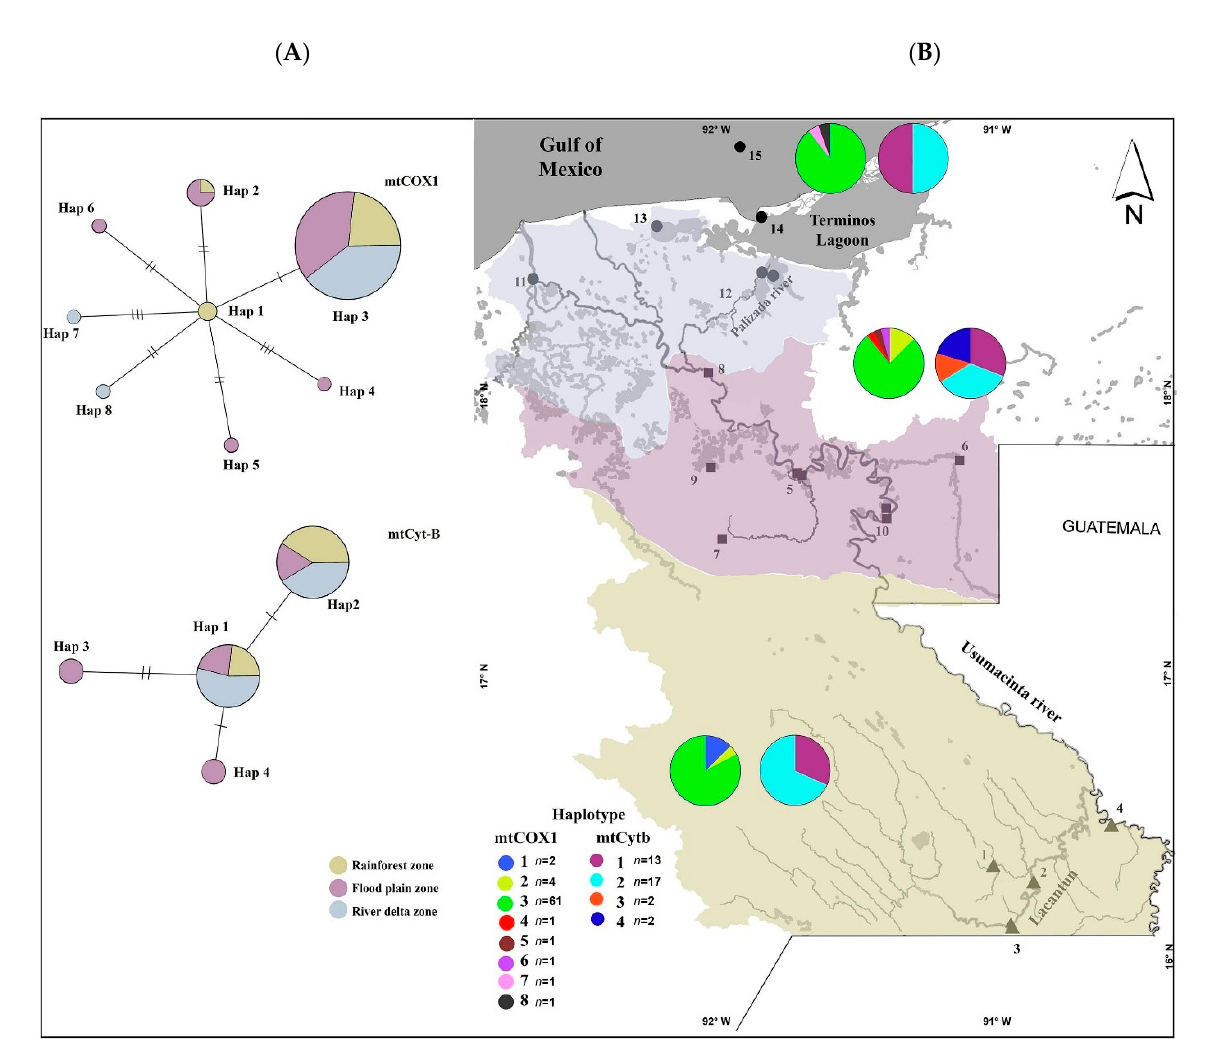
Figure 2. ( A ) ML haplotype networks for mtCox1 and mtCytb. The area of the circles is proportional to the number of sequences found for each haplotype. Partitions and colors inside the circles represent the proportion of each zone within each haplotype. ( B ) Frequencies and geographic distribution of mtCox1 and mtCytb haplotypes determined by combining allelic variants. The polygon indicates the distribution within the sampled area (rainforest, floodplain and river delta); n represents the number of sequences by haplotype. Table 2. Analysis of molecular variance (AMOVA) for two mitochondrial and nine microsatellite loci, among zones (rainforest, floodplain and river delta) and groups obtained with DAPC and STRUCTURE. Significant values are shown Table 1. Genetic diversity estimations of mtDNA for each zone of the common snook ( Centropomus undecimalis ): n = num- with the asterisk ( p < ber of sequences; h = number of haplotypes; H d = haplotypic diversity; S = number of variable sites; k = average pairwise nucleotide differences; π = nucleotide diversity. Summary statistics for nine polymorphic microsatellite loci: n = number of individuals with amplification; N a = number of alleles per locus; N e = effective number of alleles per locus; H O = observed heterozygosity; H e = expected heterozygosity; F IS = fixation index given for each locus. Values with the asterisk represent significant deviations from Hardy–Weinberg equilibrium.